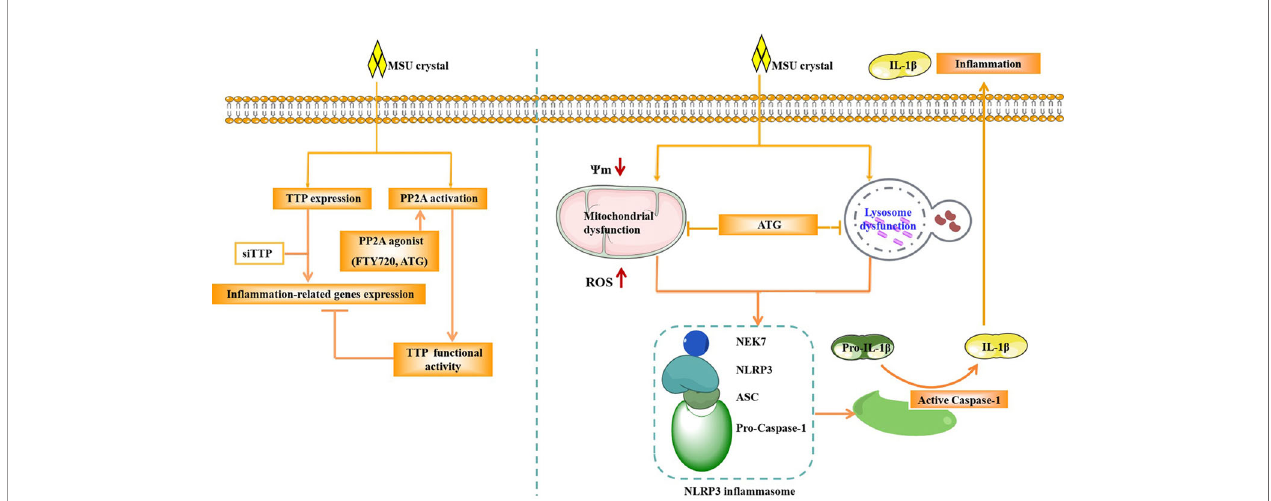
FIGURE 9 | Schematic of the signaling pathway involved in TTP and PP2A activity in the MSU crystal-induced in fl ammatory response. After MSU crystal stimulation, TTP expression and PP2A activity were increased. TTP knockdown promoted the expression of in fl ammation-related genes induced by MSU crystals. However, PP2A agonist (ATG) treatment relieved the expression of in fl ammation-related genes induced by MSU crystals. ATG may alleviate the production of mitochondrial reactive oxygen species, increase mitochondrial membrane potential and improve lysosomal function, thereby inhibiting the activity of NLRP3 in fl ammasome, and ultimately reducing the in fl ammation caused by MSU